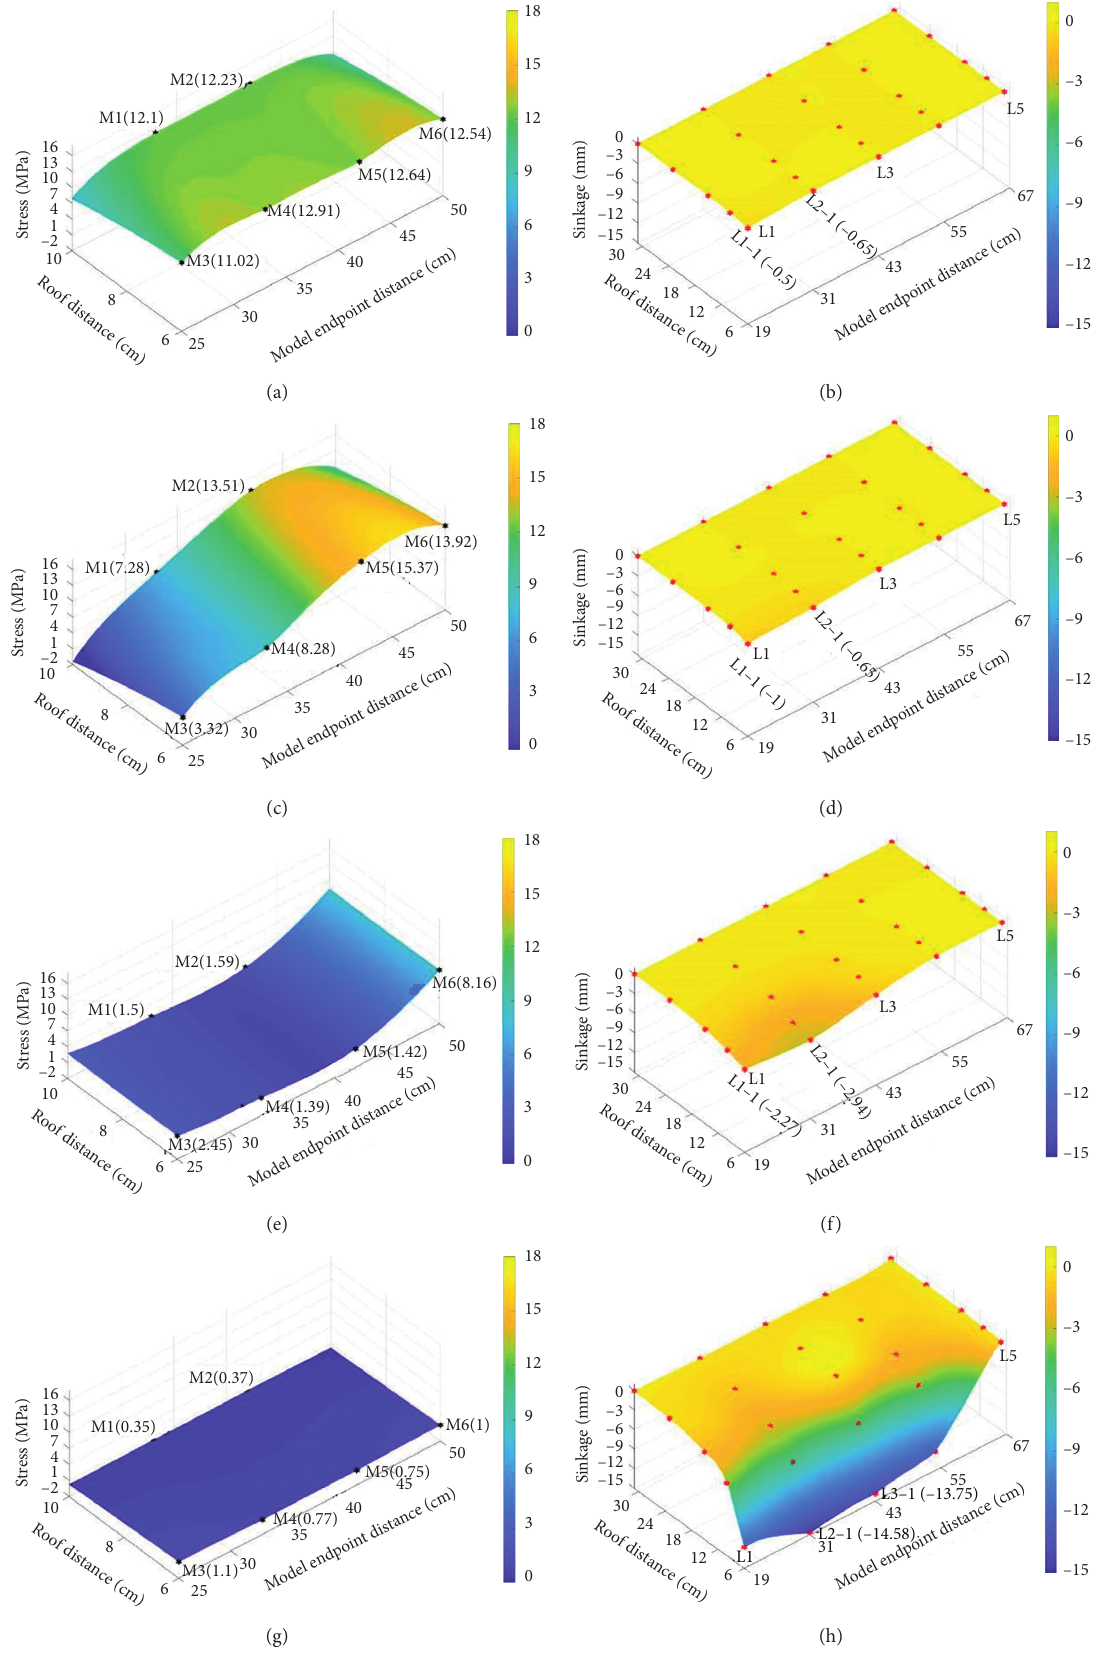
Figure 6: Lower roof stress and overlying rock subsidence for the four-step excavation of the stope structure with 3m ore pillars: (a, b) first step; (c, d) second step; (e, f) third step; and (g, h) fourth